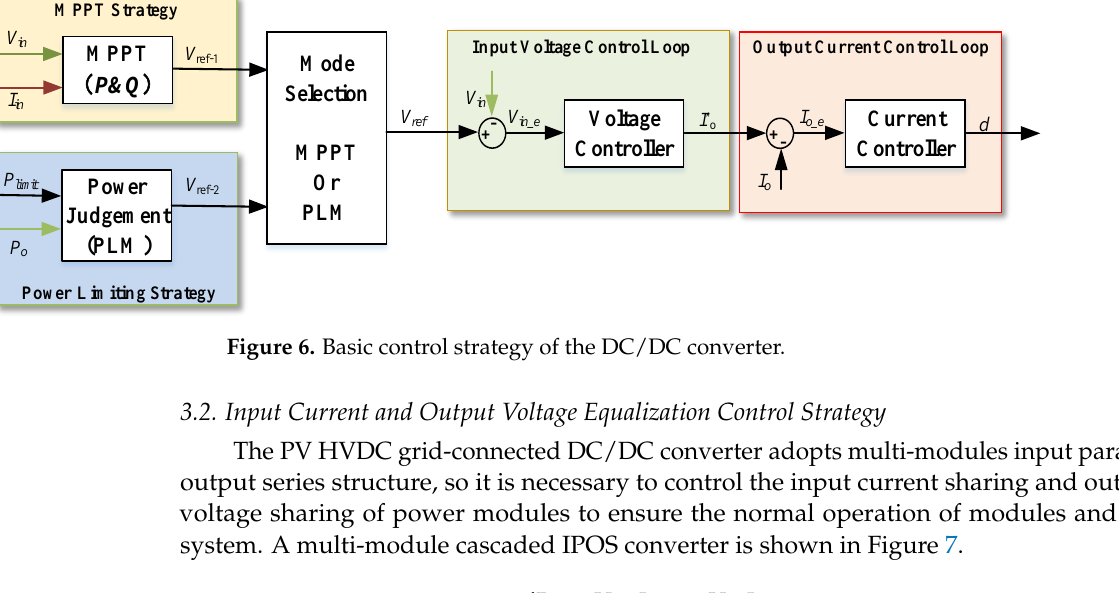
Figure 7. IPOS module cascaded PV HVDC converter. 1